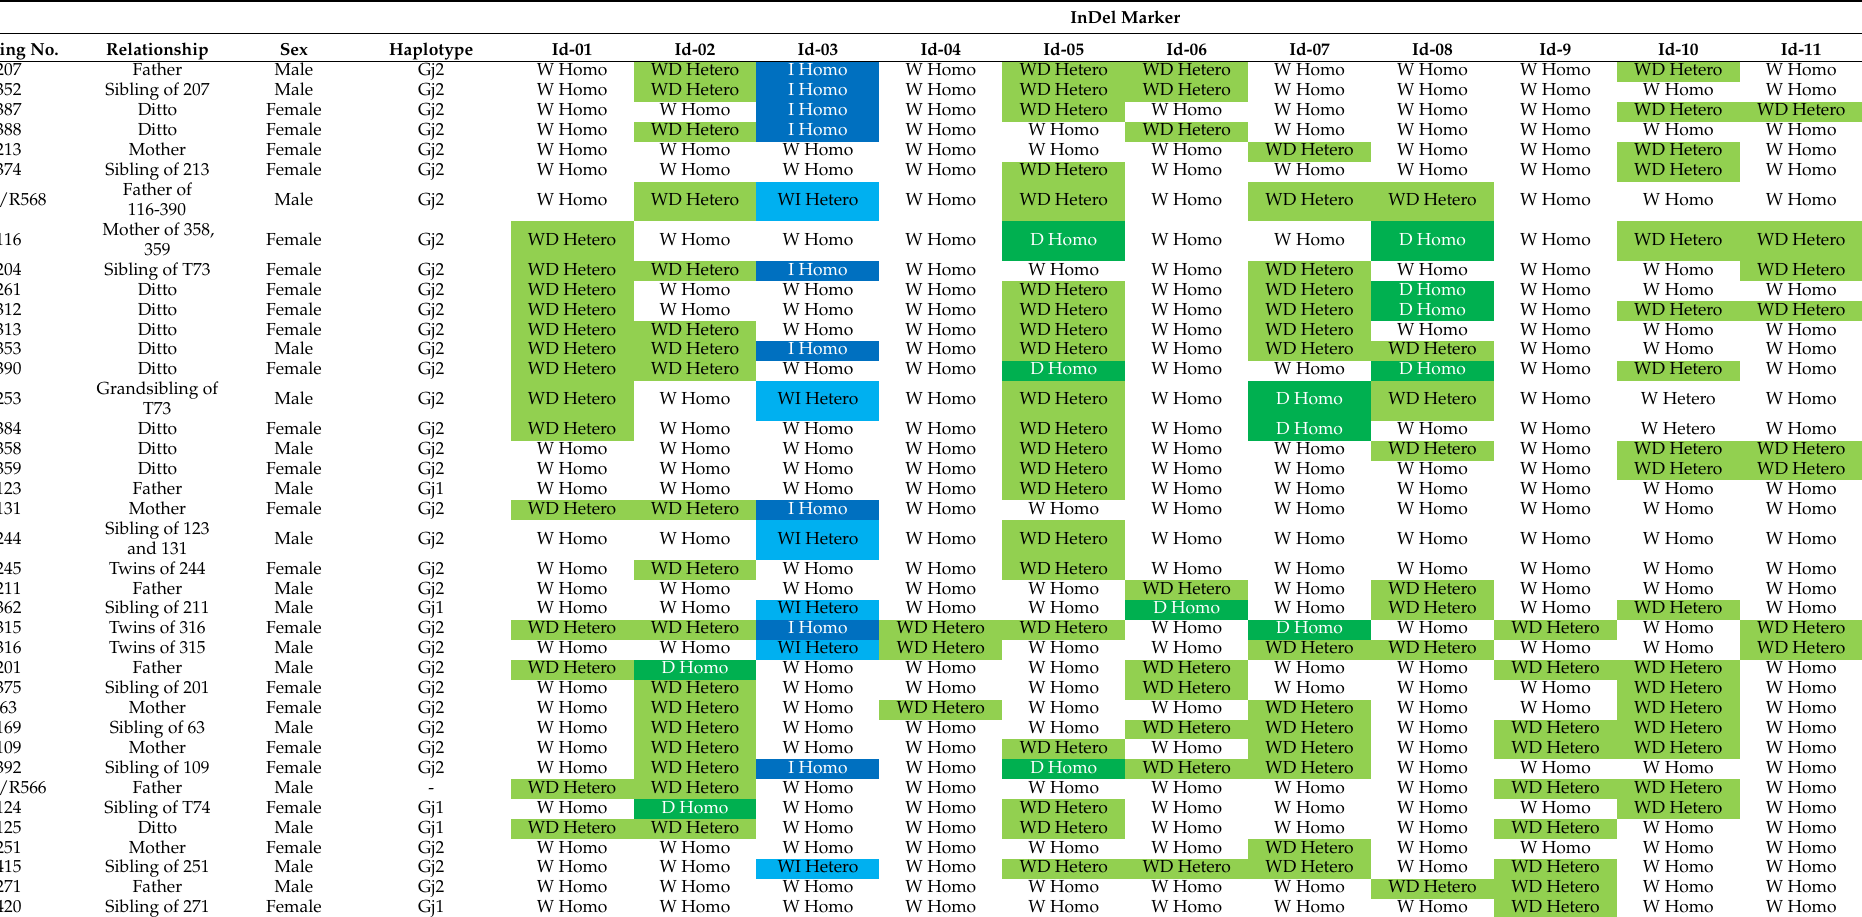
Table 5. Summarized InDel patterns and the other information of individual red-crowned cranes in a population containing blood relatives. Banding